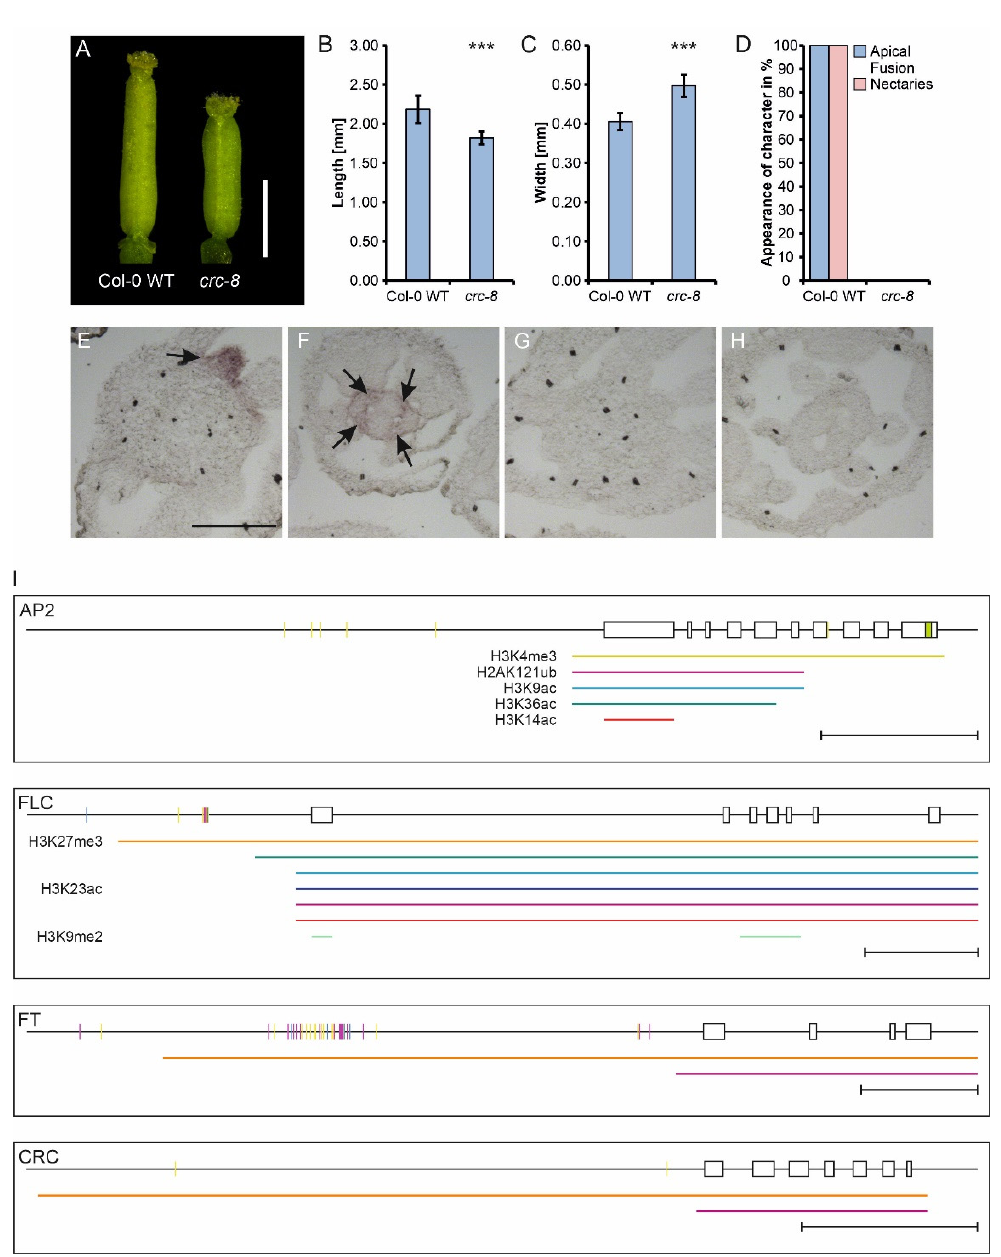
Figure 1. Arabidopsis thaliana crc-8 phenotype and summary of gene-expression regulation of AP2 , FLC , FT , and CRC . ( A ) Representative gynoecia of Col-0 wild type and crc-8 plants. Scale bar represents 1 mm. Statistical analysis of gynoecium length ( B ), width ( C ), and a summary of absence or presence of other described crc-1 phenotypes in crc-8 ( D ). Both length and width comparisons ( B , C ) are the means with standard deviation. Percent values are shown in ( D ). Student’s t -test was applied to compare the wild-type gynoecia with crc-8 and significant differences were marked with up to three asterisks ( p < 0.001), n = 100. ( E – H ) Spatial analysis of CRC expression with RNA in situ hybridization. In situ hybridization using a CRC antisense probe of A. thaliana Col-0 wild type ( E , F ) and crc-8 ( G , H ), showing gynoecia ( E , G ) and nectaries ( F , H ). Nectaries and internal CRC expression marked with arrows. ( I ) Summary of gene-expression regulation of AP2, FLC, FT, and CRC . Shown are the promoter regions and the exon or intron structure of the respective gene with exons shown as boxes. DNA methylation is shown in short purple (CG), blue (CHG), and yellow (CHH) vertical lines. Colored horizontal lines under the genomic locus indicate regions of histone modifications identified with PlantPAN in leaf tissue: the activating marks H3K4me3 (yellow), H3K9ac (light blue), H3K14ac (red), H3K23ac (dark blue), H3K36ac (dark green), and the repressing marks H2AK121ub (magenta), H3K9me2 (light green), and H3K27me3 (orange). Sorting into activating or